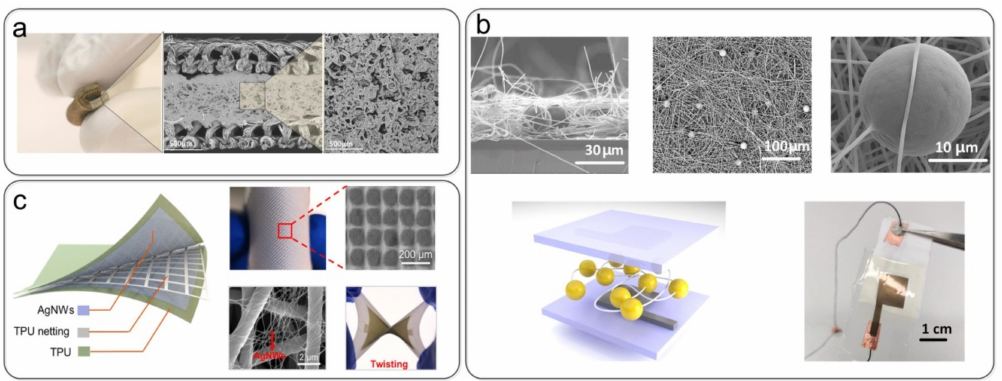
Figure 7. Capacitive pressure sensor based on the sandwich devices. ( a ) Combining soft conductive fabrics (knitted and woven fabrics) and microporous dielectric layers (sugar particles and salt crystals) to prepare capacitive pressure sensors. Reproduced with permission from Ref. [100]. Copyright 2017 Wiley-VCH. ( b ) Electrospinning to prepare dielectric membranes composed of insulating microbeads within PVDF nanofibers. Reproduced with permission from Ref. [135]. Copyright 2020 American Chemical Society. ( c ) All-fabric capacitive pressure sensor based on a micropattern nanofiber dielectric layer. Reproduced with permission from Ref. [110]. Copyright 2021 American Chemical